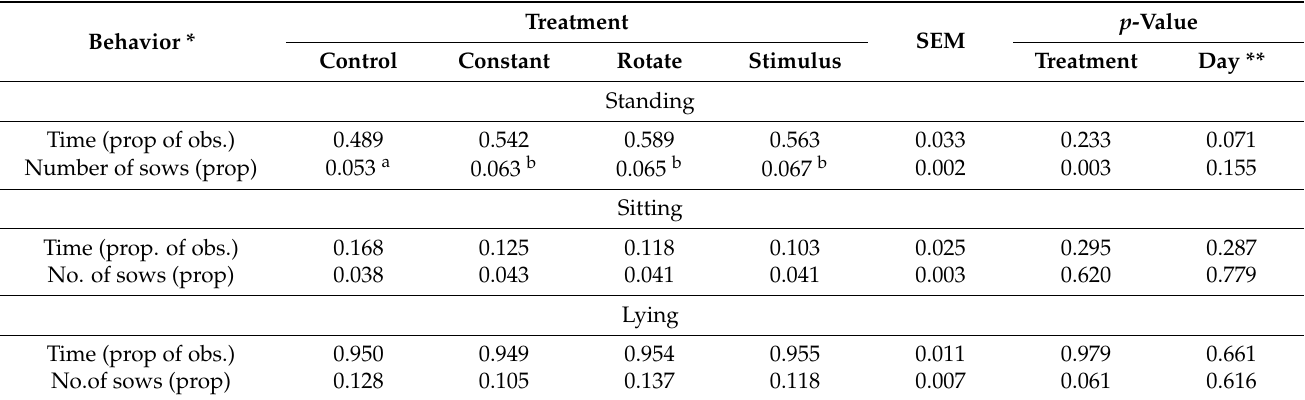
Table 3. Effects of enrichment treatment and day of observation on the postures of sows observed in photo scans. LS Means of duration (prop. of observations) and number of sows in each posture (prop. of sows).